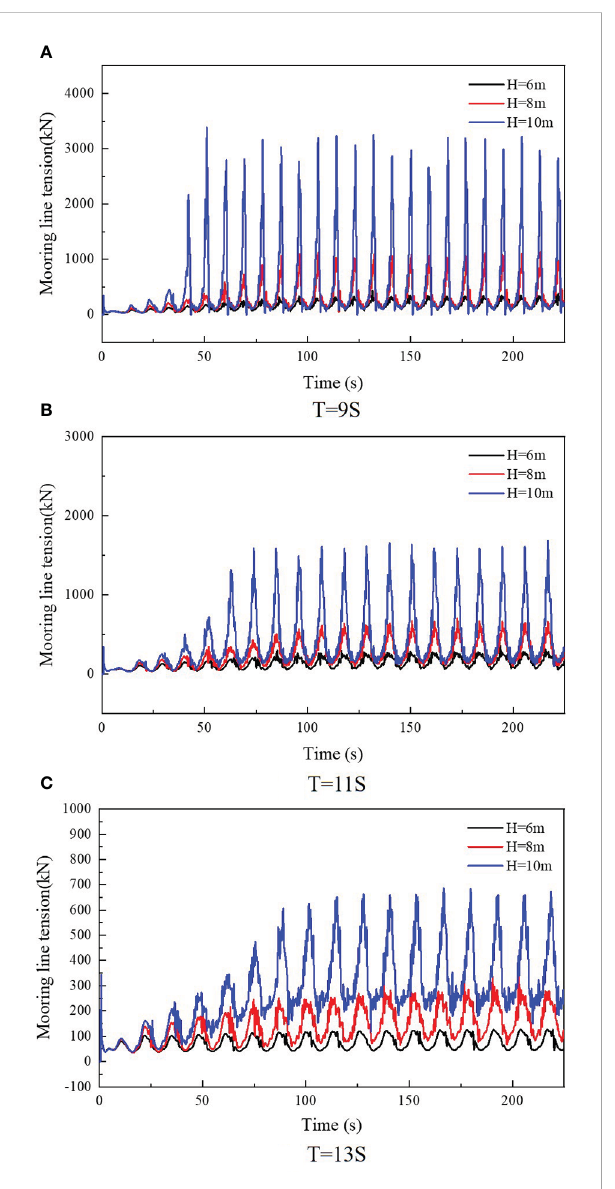
FIGURE 11 Mooring line tension of fi sh farm platform under different wave conditions.